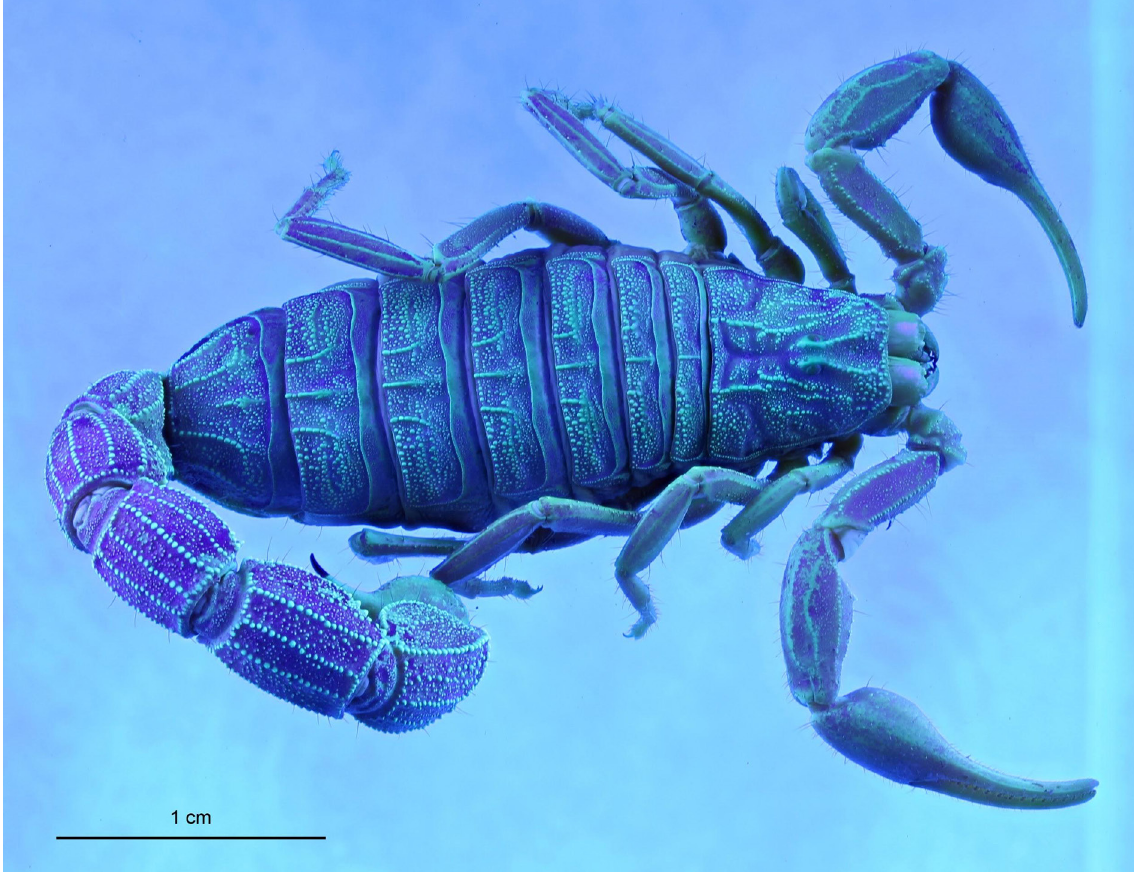
Fig. 4.1. Scorpion pictured in UV fluorescence. Focus stacking